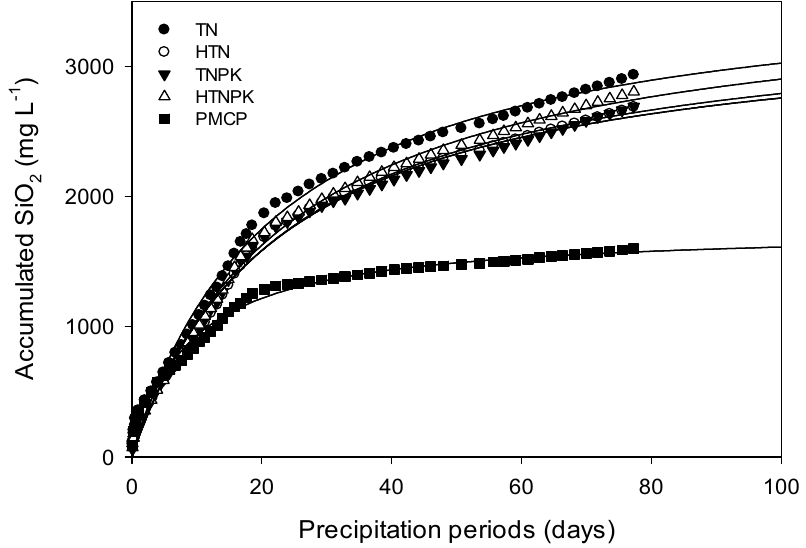
Figure 4. Releasing curves of SiO 2 from the blended biochar pellet uploaded with different plant nutrient solutions. The results are mean of triplicate samples. Error bars indicate standard deviation.